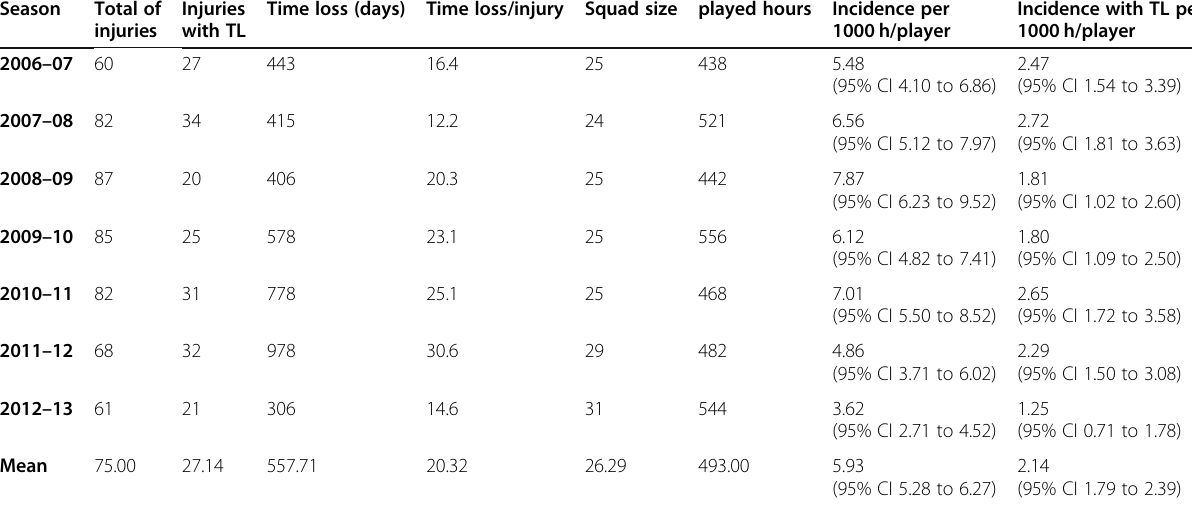
Table 1 Summary of different Seasons and the respective injury incidence with and without time loss (TL)